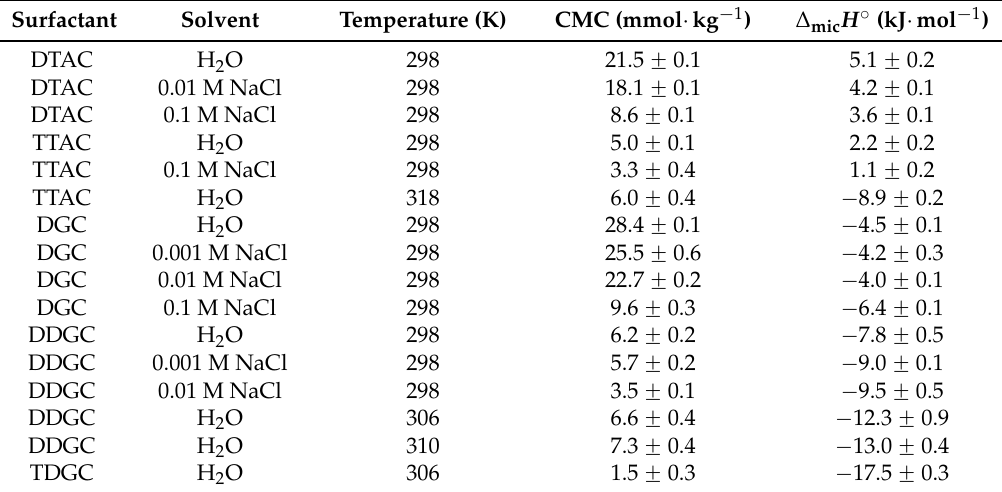
Table 3. Critical micelle concentration, CMC, and standard enthalpy of micelle formation per mole of the surfactant, ∆ mic H ˝ , for guanidinium cationic